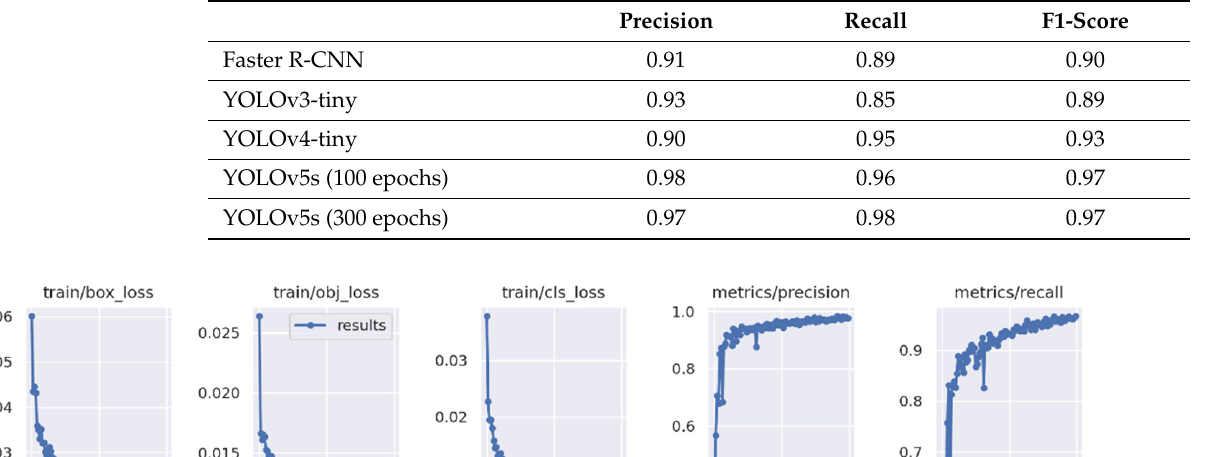
Table 3. Performance comparisons of different deep learning algorithms (cont’d).